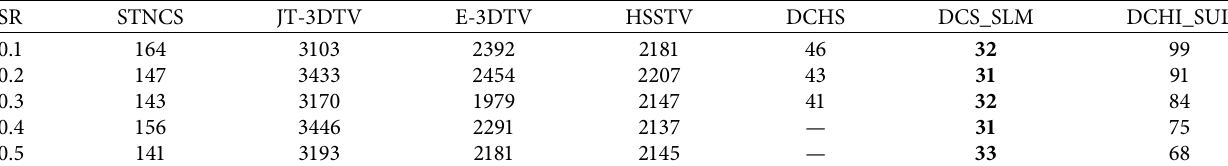
Table 4: Runtime ( s ) comparison of all competing methods on Yellowstone 0